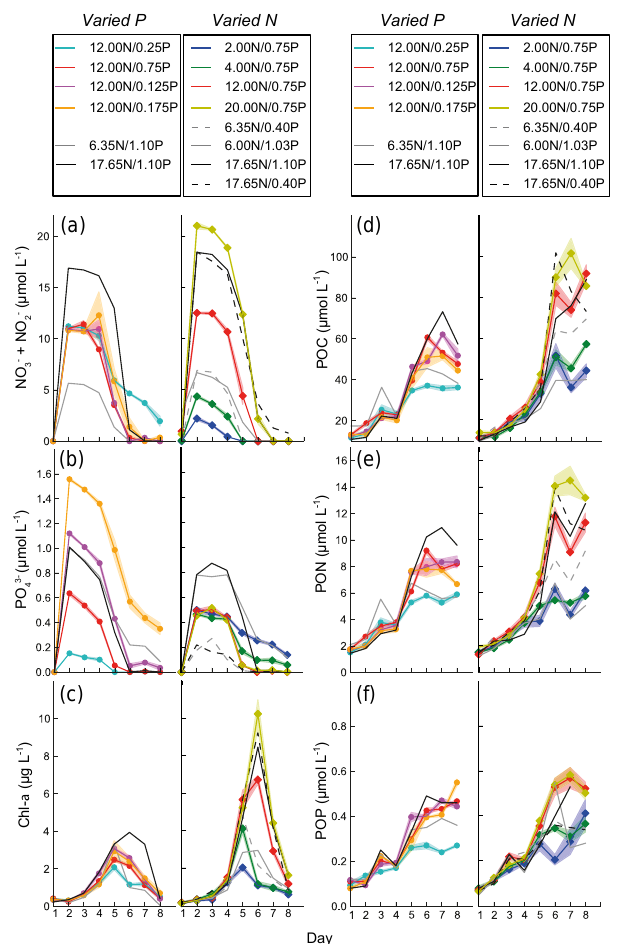
Figure 2. Temporal development of (a) NO − (c) Chl a , (d) POC, (e) PON and (f) POP within all treatments of both experimental runs. Standard deviations are depicted as shaded error